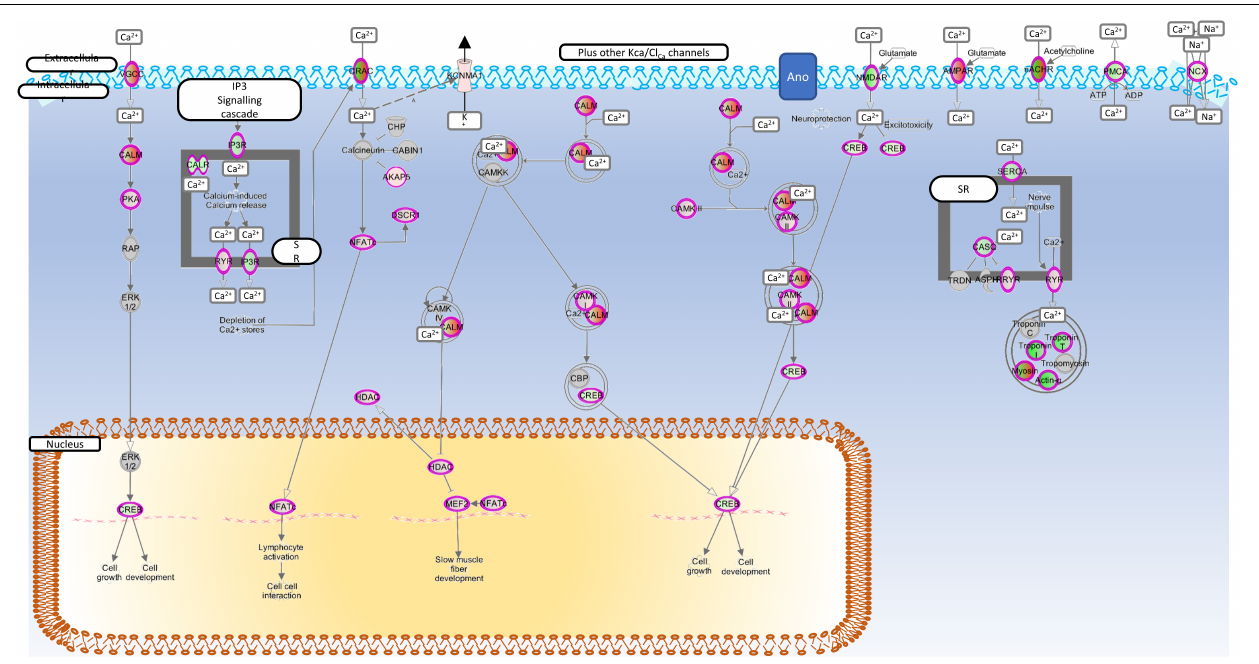
FIGURE 3 | Enriched calcium regulation pathway. Genes mapped to the calcium signaling canonical pathway by IPA. Red, increased expression; green, decreased expression (for interpretation of the references to color in the figure legend, please refer to the online version of this article).